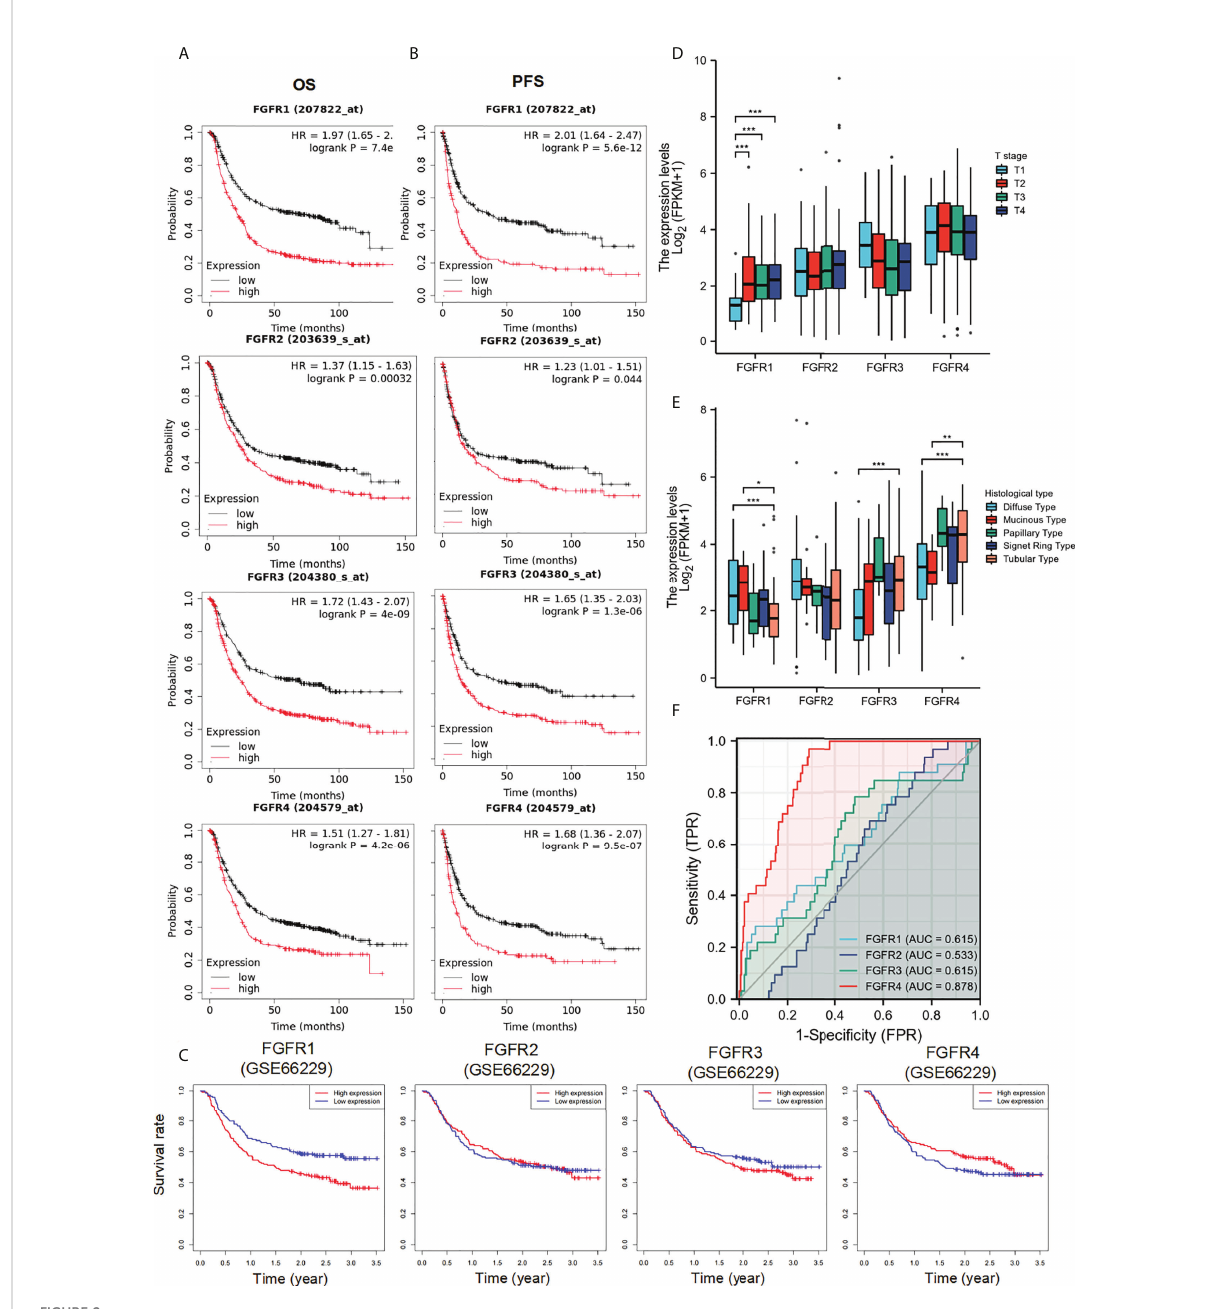
FIGURE 2 The diagnostic and prognostic value of FGFRs in GC. (A, B) The OS (A) and PFS (B) survival curves of FGFRs in TCGA-STAD in Kaplan – Meier plot databases. (C) The OS survival curves of FGFRs in GSE66229 database. (D, E) The expression of FGFRs in different T stages (D) and histologies (E) were analyzed in TCGA-STAD data sets. (F) ROC curve analysis of FGFRs in the diagnosis of GC. *p < 0.05; **p < 0.01; ***p < 0.001; OS, overall survival; PFS, progression-free survival; GC, gastric